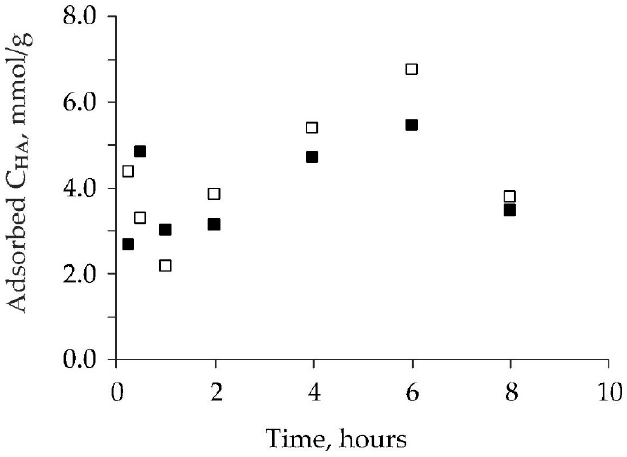
Figure 6. The dependence of the adsorbed amount of C HA on the time of interaction with Al 13 -bentonite. Empty and filled icons—repetition of an experiment.